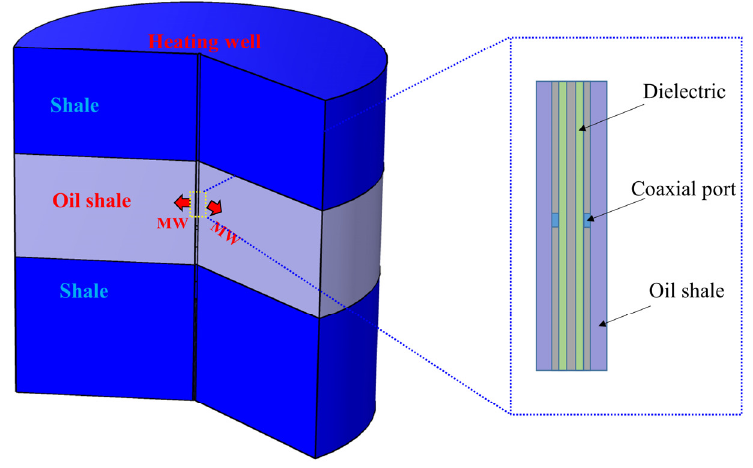
Figure 2. Pseudo three-dimensional model for the oil shale in situ retorting under microwave irradiation. Table 2. Initial conditions and parameters of the proposed